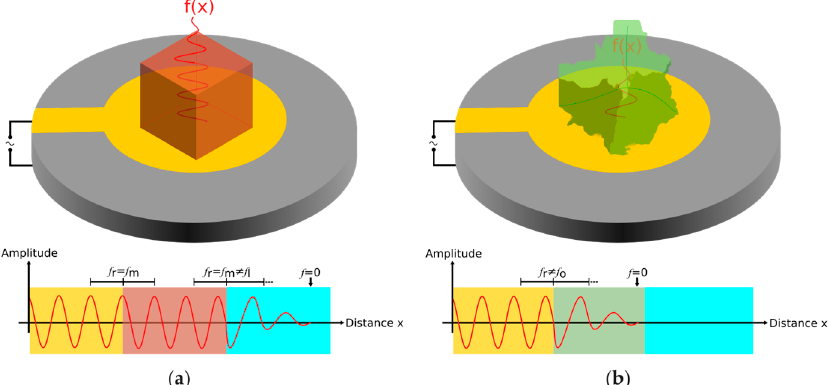
Figure 1. QCM working principle for rigid and viscoelastic masses. The upper part of the figure shows a quartz resonator surface with a deposited mass. For ( a ) this mass is rigid and therefore vibrates in the same resonant frequency as the quartz itself. In ( b ) the deposited mass is viscoelastic, thus cannot follow the vibrational acceleration which results in energy dissipation, and subsequently in mass underestimation. The plots illustrate the frequency amplitude versus distance from the quartz resonator surface (yellow), where f r : resonant frequency, f m : frequency of rigid mass, f l : frequency in liquid phase, and f o : frequency of viscoelastic mass. In ( a ), a depletion can only be seen when the wave leaves the rigid mass (brown) and hits liquid (blue). Due to the viscoelastic mass in ( b ), the decay length is much shorter and the vibrational wave cannot penetrate the entire mass (decay length typically 250 nm